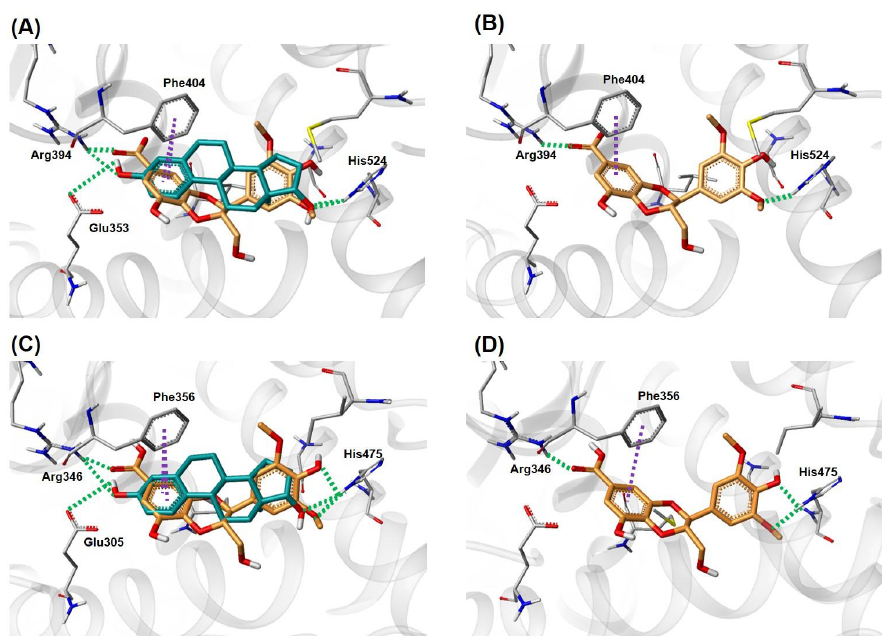
Figure 5. Proposed binding pose of compound 1 in the active site of ER- α (PDB id: 1A52) and ER- β (PDB id: 5TOA). The docked pose of 1 and the co-crystalized pose of 17 β -estradiol were superimposed in the active site of ER- α ( A ) and ER- β ( C ). All atoms of the ligands and amino acid residues are colored by atom type: carbon atoms are colored green-blue (17 β -estradiol), orange ( 1 ), and grey (amino acid residues); nitrogen is blue; oxygen is red; sulfur is yellow; and hydrogen is white. The hydrogen bonds are indicated as green dashes and π - π interactions as purple dashes. The docked pose of 1 in the ligand-binding pocket of ER- α ( B ) and ER- β ( D ). Table 2. Calculated Gibbs free binding energy for 1 :ER versus the 17β -estradiol:ER complex. ER- α (pdb id: 1A52) ER- β (pdb id: 5TOA) Surflex- Gibbs Free Surflex- Gibbs Free Ligand Dock Score K d Energy * ( ⊿ Ligand Dock Score K d Energy * ( ⊿ ( − log K d ) G bind ) ( − logK d ) G bind ) 1 1.7299 1.86*10^( − 2) estradiol